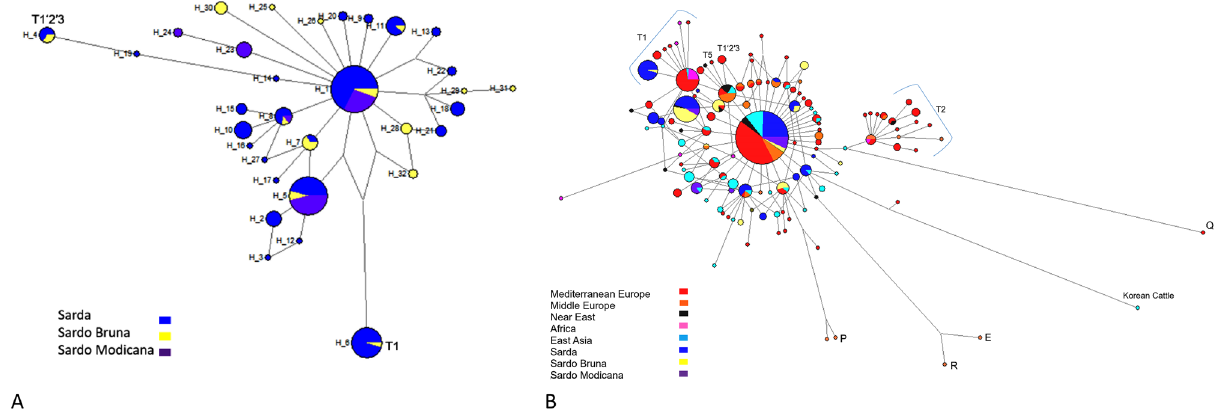
Figure 2. ( A ) Median Joining Network based on mtDNA hypervariable sequence haplotypes of 157 Sardinian cattle, including sequences from Sarda, Sardo Bruna and Sardo Modicana cattle breeds. T1 and T1,2,3 indicate the Haplogroup assignment. Aligned sequences were 616 bp long. ( B ) Median joining network based on mtDNA hypervariable sequence haplotypes of 586 sequences from 157 Sardinian cattle and European, Asian and African bovines retrieved from public databases and representative of all known mitochondrial haplogroups. Sequences have been trimmed to obtain an alignment of 487 bp. Mediterranean Europe included sequences from Italy (North, South, Center), Spain, Portugal, and France. Central Europe encompassed sequences from Germany, Denmark, Romania, Bosnia, Croatia, Bulgaria. Near East comprised sequences